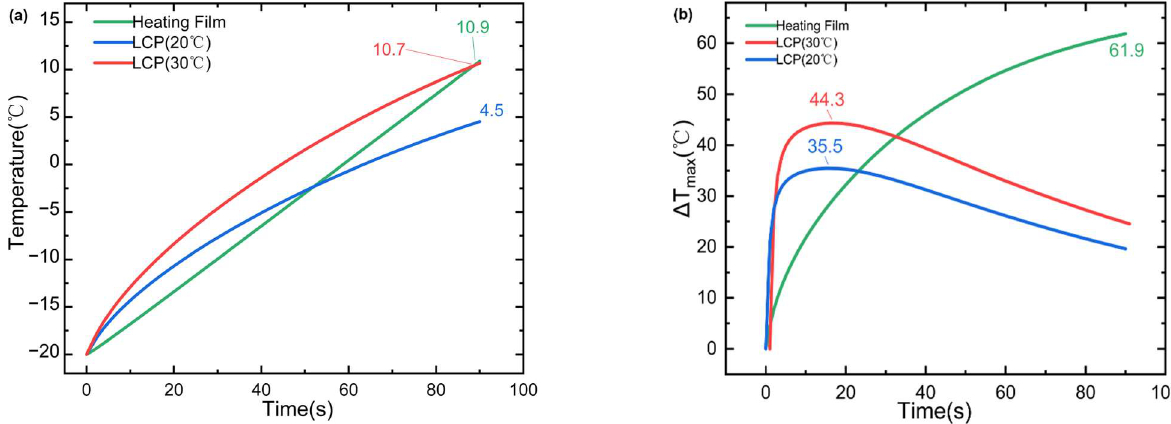
Figure 7. Temperature profile of two heating methods. ( a ) Average temperature; ( b ) Maximum temperature of the cell surface after 90 s of heating by LCP and HF.